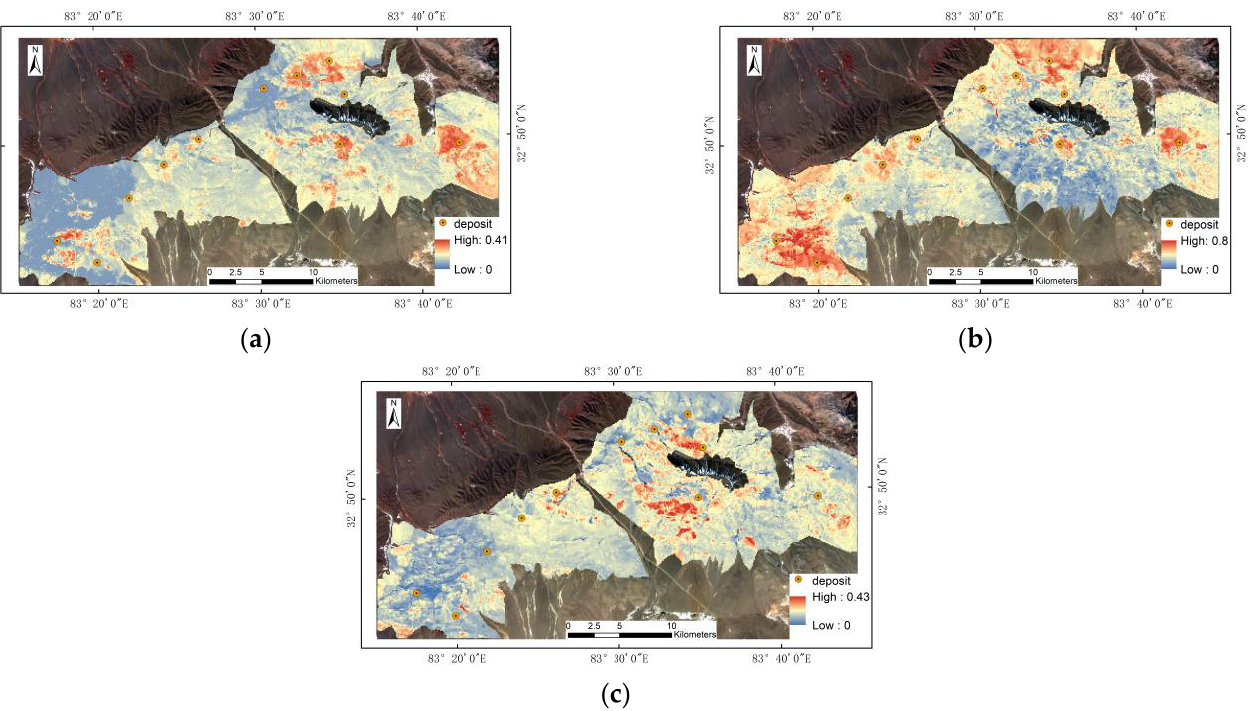
Figure 7. Mineral mapping reslts based on the GF-5 dataset in Duolong: ( a ) muscovite; ( b ) kaolinite; and ( c ) chlorite. The value denotes the abundance of alteration minerals.